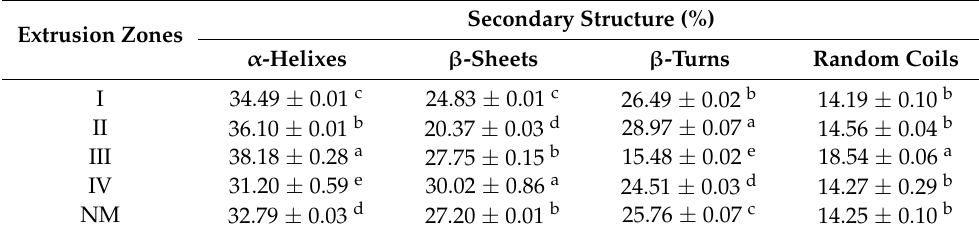
Table 3. Secondary structure of oats protein at 20%